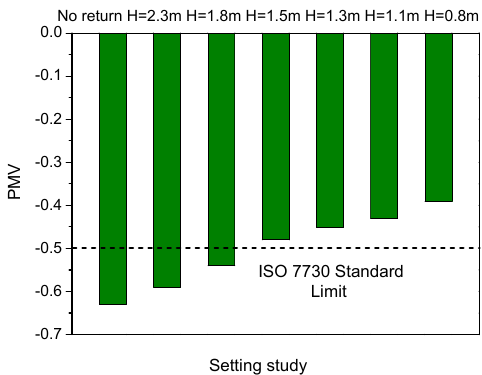
Figure 6. Predicted mean vote (PMV) index for different settings.